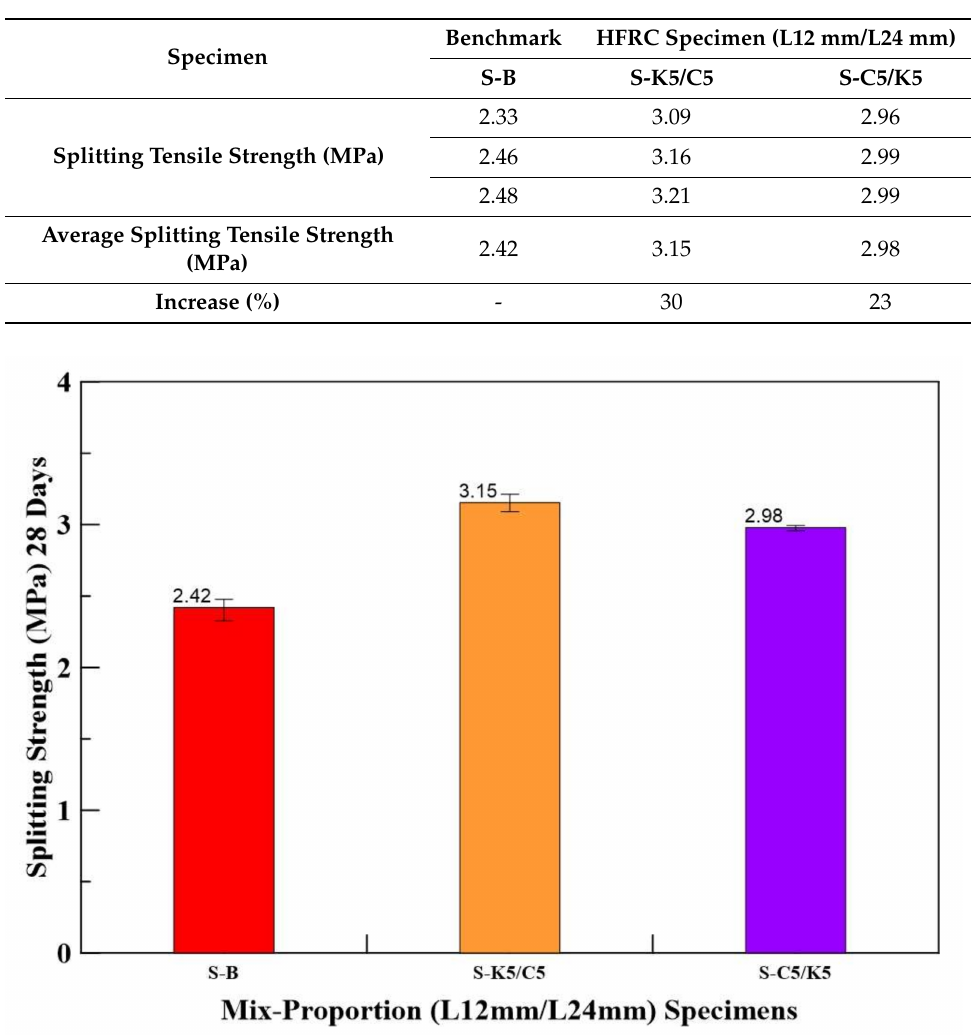
Table 8. Splitting tensile strengths of benchmark and HFRC specimens.